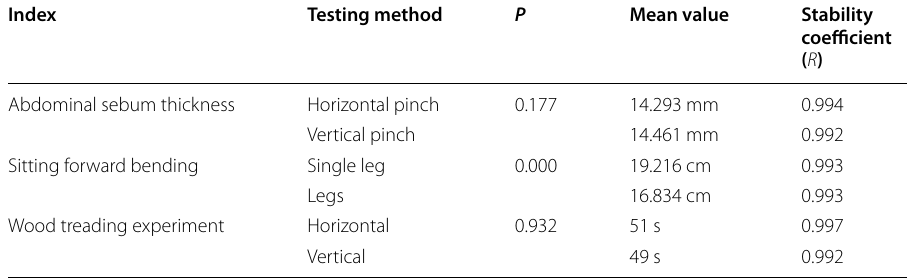
Table 3 Experimental results of two test methods for partial sebum, sitting body forward flexion, and static balance